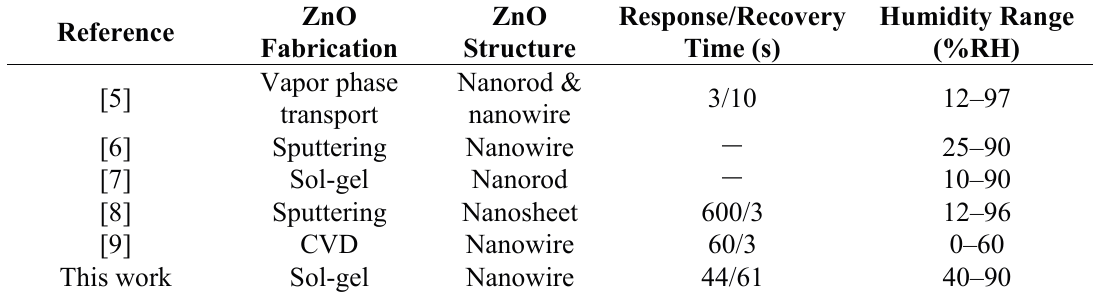
Table 1. ZnO structures and performances of the humidity sensors in